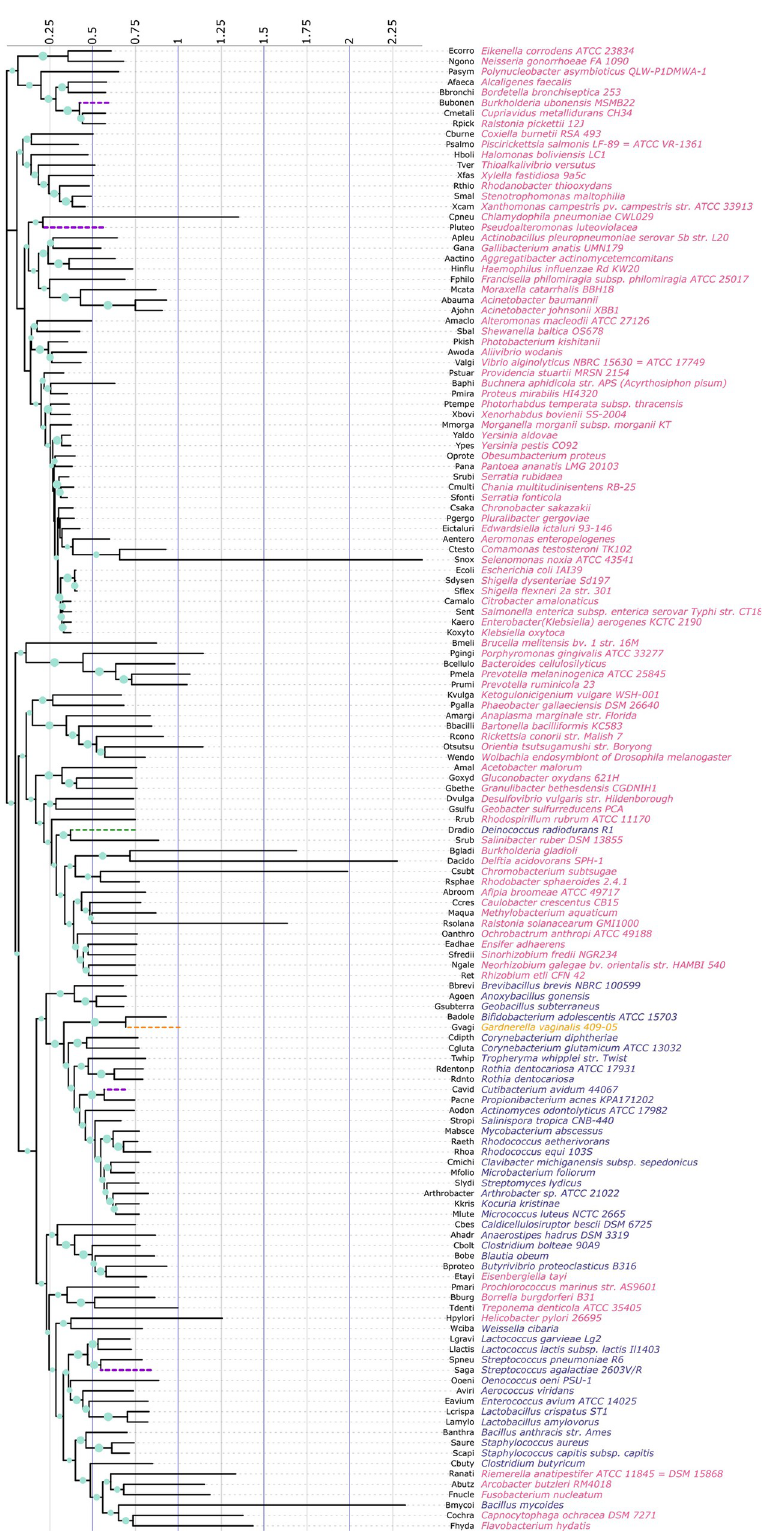
Fig 12. A phylogenetic tree depicting the evolutionary relationship between the 143 ftsZ CDS considered in this study constructed using MEGA X and annotated using iTOL. The evolutionary history was inferred using the